Question: In one sentence, what is this figure communicating?
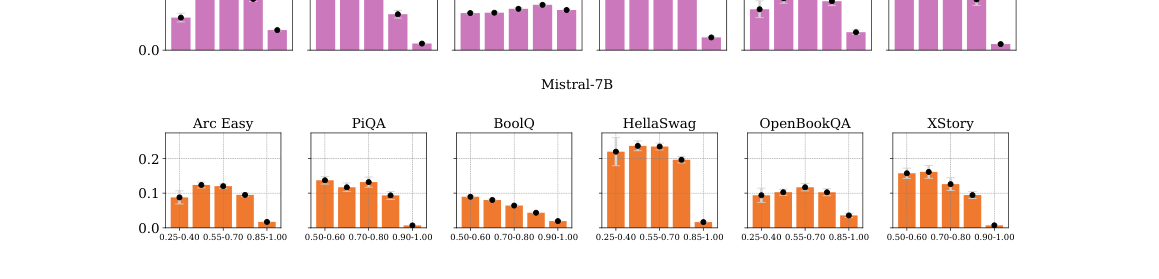
Answer: Confidence difference for models across datasets. For each dataset (in column) and each model (in line), we provide the difference in prediction scores between the full and quantized models. More precisely, each bar represents the mean difference in confidence between the quantized and full models, with confidence in the full model represented on the horizontal axis. Note that some ranges start from 0.5 for binary tasks and 0.25 for multi-class (with four classes) tasks. For a confidence lower than the previous one, there is no chance of being assigned to the associated class.